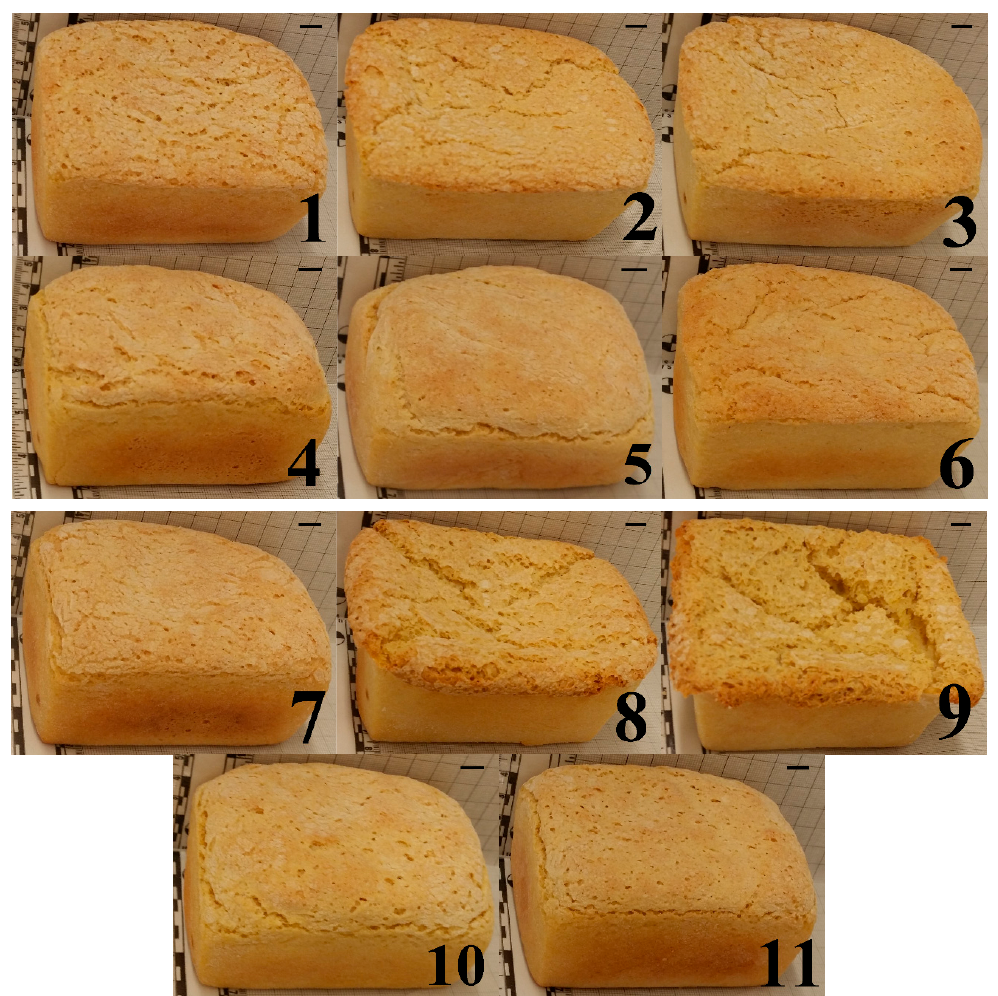
Figure 2. Height and crust appearance of the eleven treatments of gluten-free bread produced by varying xanthan, guar and HPMC hydrocolloids. Formulations correspond to those shown in Table 1 (Scale bars = 1 cm).